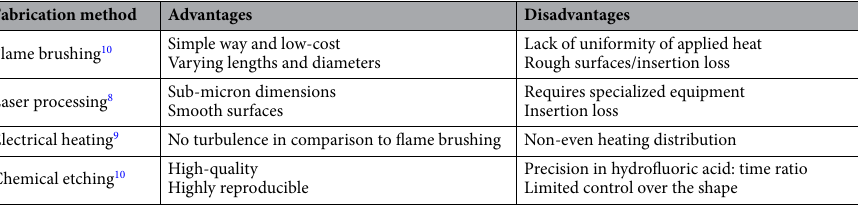
Table 1. Tapered optical fiber fabrication methods.